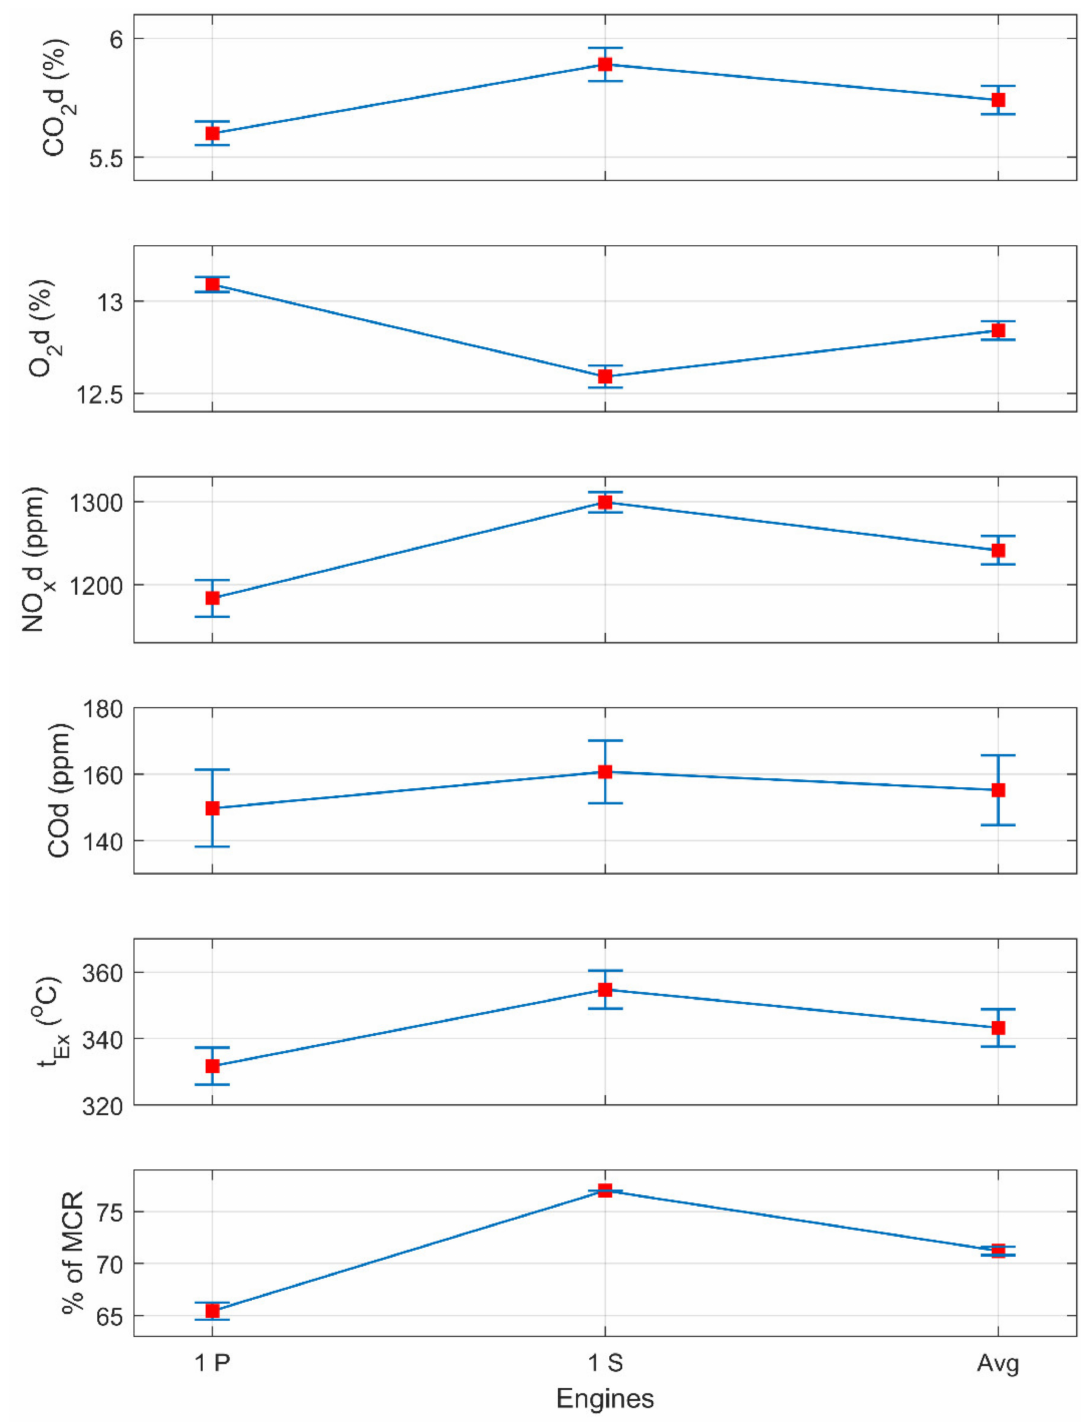
Figure 8. Mean µ and standard deviation σ of measured and analysed parameters for Vessel 2 and its associated port (P) and starboard (S) engines with calculated average